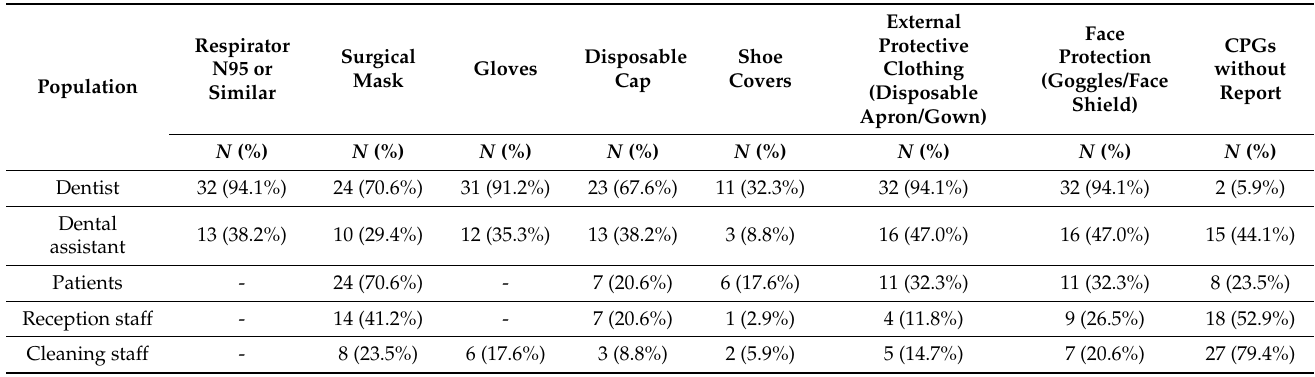
Table 4. Recommendations for use of personal protective equipment (PPE) by dentists, dental assistants, patients, reception staff, and cleaning